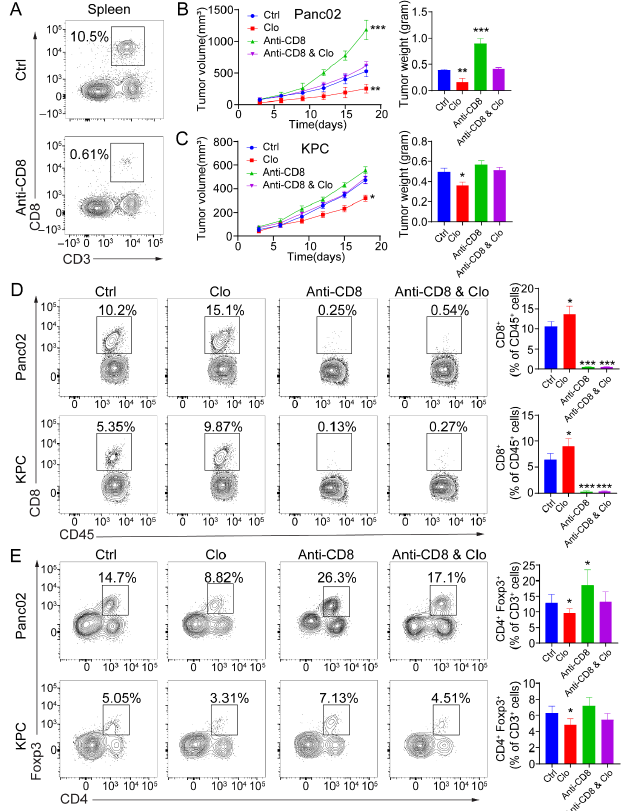
Figure 5. The antitumor response induced by targeting macrophages is CD8 + T ‐ cell ‐ dependent. ( A ) Representative flow cytometric analysis of CD8 + T cells to confirm depletion was carried out. ( B , C ) Mice were treated with 200 μ L (intraperitoneal injection) of control liposomes or clodronate lipo ‐ somes on days − 1 and 0 and every 3 days afterward, and/or with isotype control or anti ‐ CD8 anti ‐ bodies on days − 1, 0, 5, 10, and 15 ( n = 5 mice/group). Left : tumor growth curves showing the vol ‐ umes of subcutaneously implanted tumors in mice ( n = 5 per group) treated with control liposomes or clodronate liposomes. Right: final tumor weights. ( D , E ) Flow cytometric analysis of tumor ‐ infil ‐ trating CD8 + T cells ( D ) and Foxp3 + Tregs ( E ). Each data point represents a mouse. Data are shown as the mean ± SEM. Statistical analyses were performed by one ‐ way ANOVA with Tukey’s correc ‐ tion for multiple comparisons. *: p ≤ 0.05, **: p ≤ 0.01, ***: p ≤ 0.001.